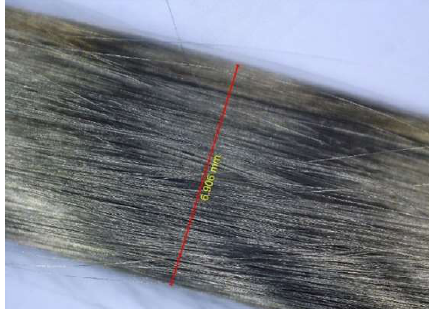
Figure 2. An image of Tenax ® -J HTS40 1420tex NiCCY provided by Toho Tenax Europe GmbH, Wuppertal, Germany. The image was taken with OneBird Smart 5M 300X USB Digital Microscope Camera Video with MicroCapture. The diameter of 6.906 mm was measured without any pretension [14].